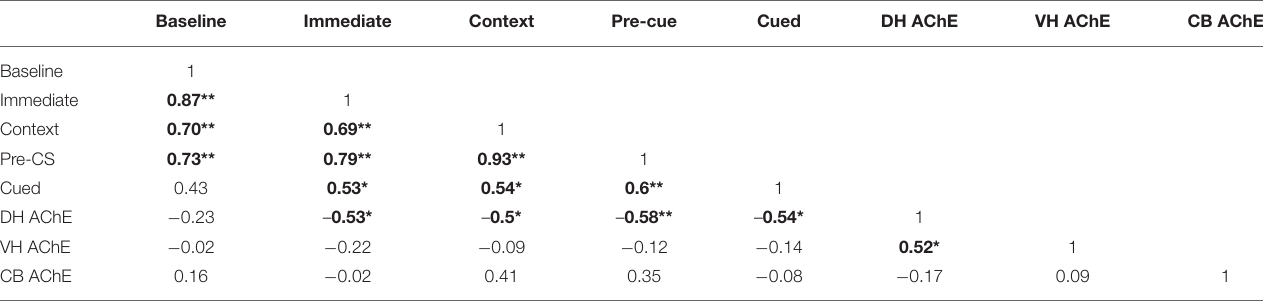
TABLE 1 | Pearson correlation coefficients of AChE activity when correlated with different components of fear learning. Baseline Immediate Context Pre-cue Cued DH AChE VH AChE CB AChE